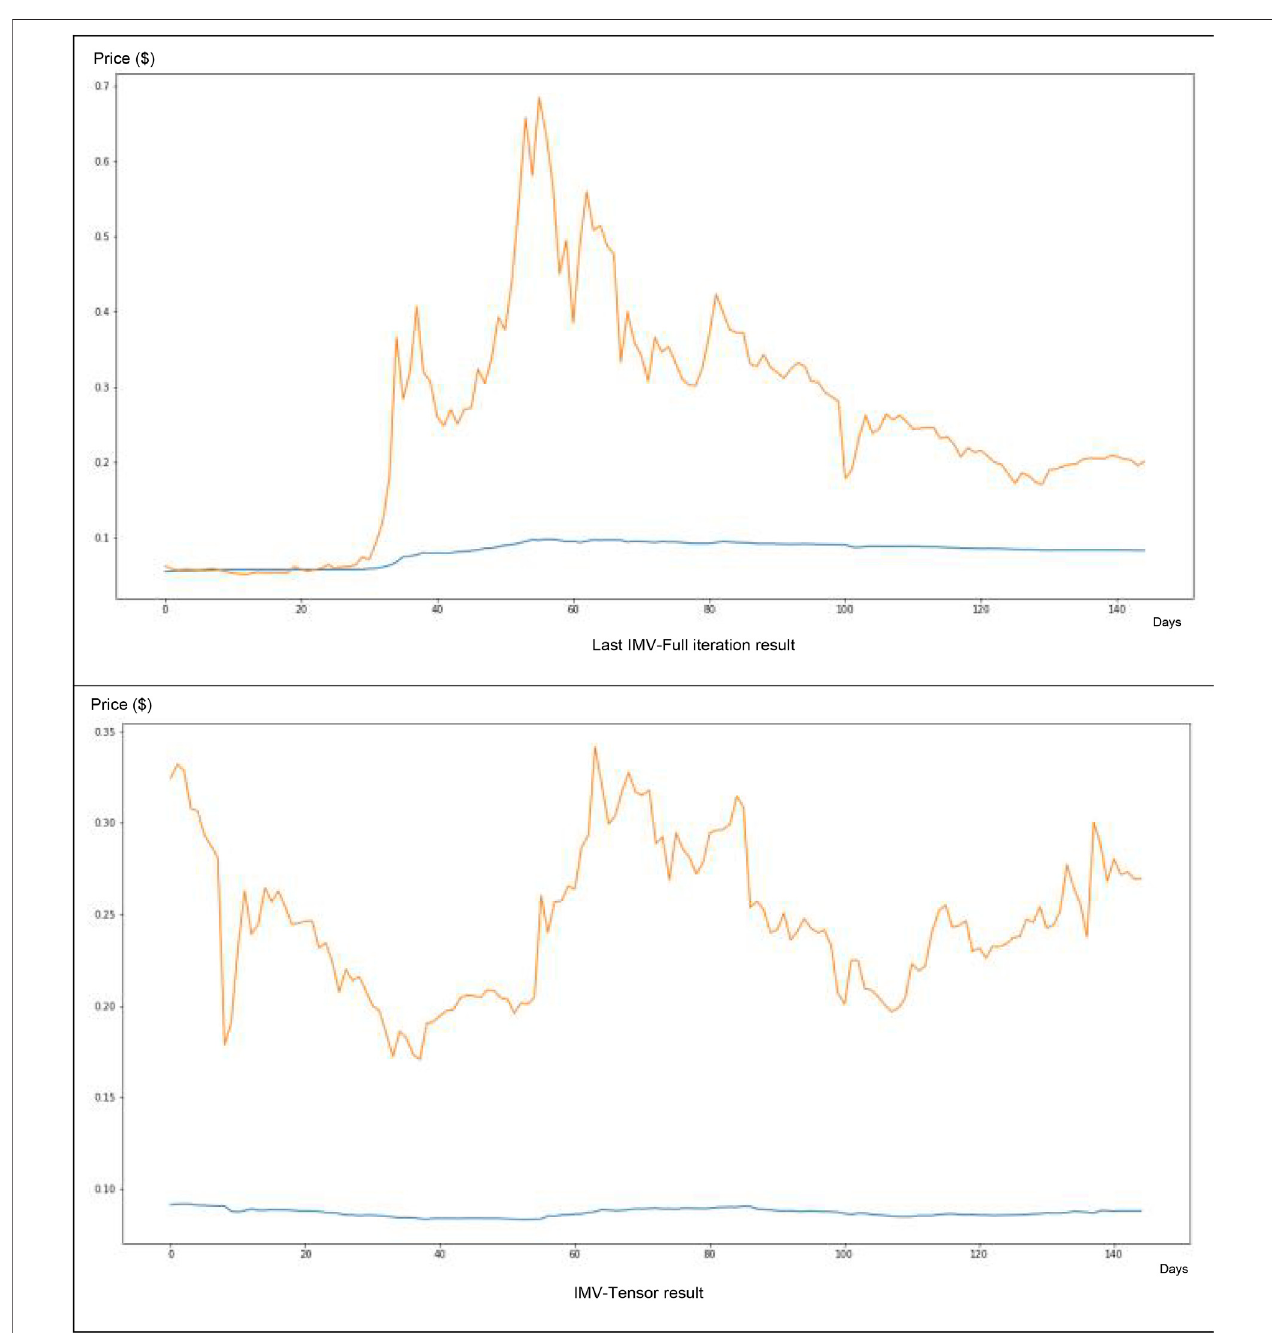
FIGURE 10 | IMV-LSTM application for Dogecoin